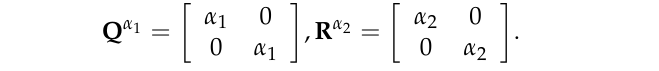
and α are uncertain. Figure 3. Average MSE of various filters when α 1 and α 2 are 1 2